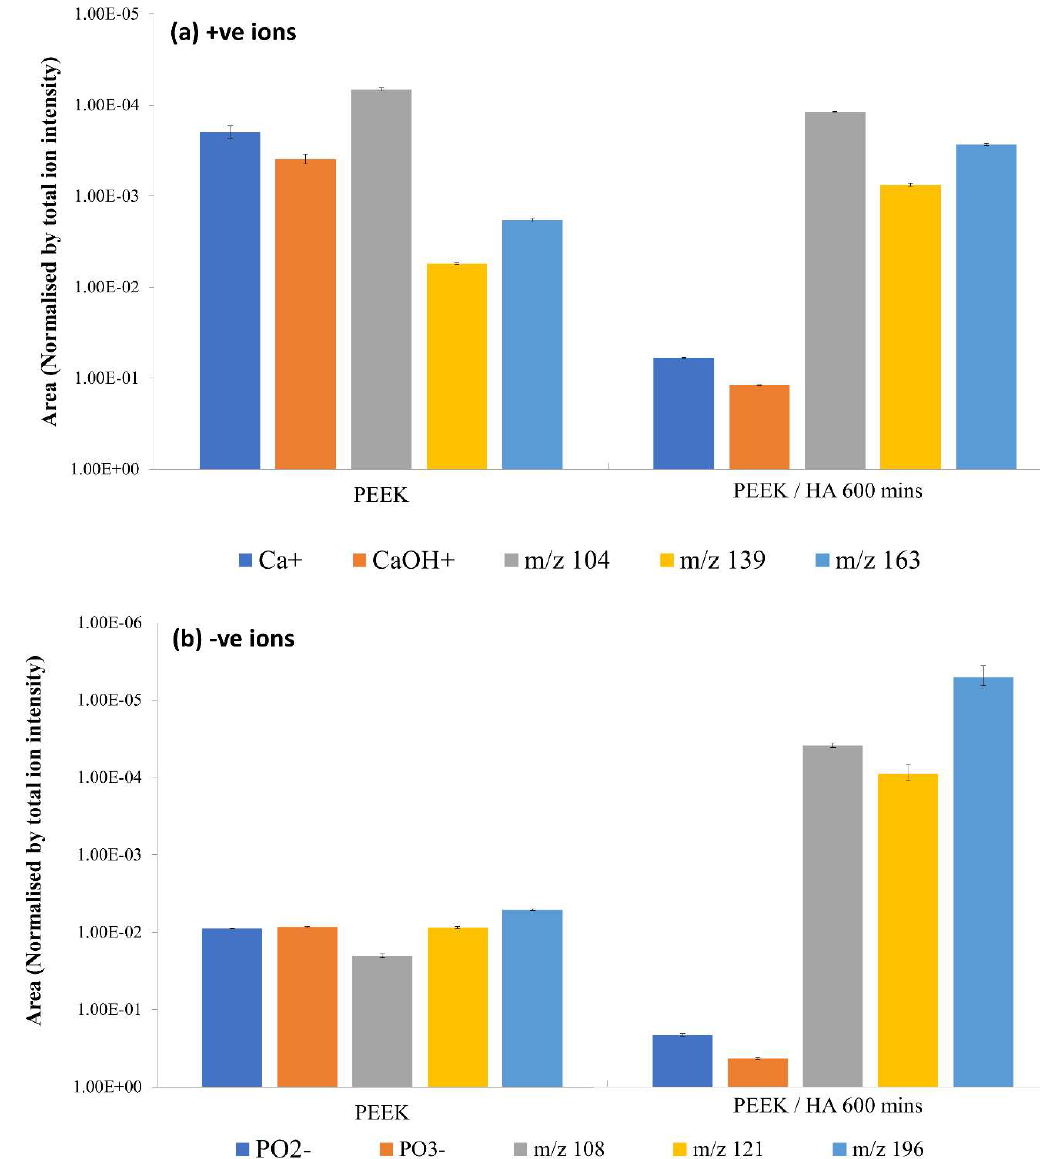
Figure 14. ( a ) PEEK substrate and HA600 positive ion intensity for the Ca + , and CaOH + , m / z 104, 139, and 163 (diagnostic PEEK fragments); ( b ) PEEK substrate and HA600 negative ion intensity for the PO 2 − and PO 3 − ions, C 6 H 4 O 2 − ( m / z 108), C 7 H 5 O 2 − ( m / z 121), and C 13 H 8 O 2 − ( m / z 196).